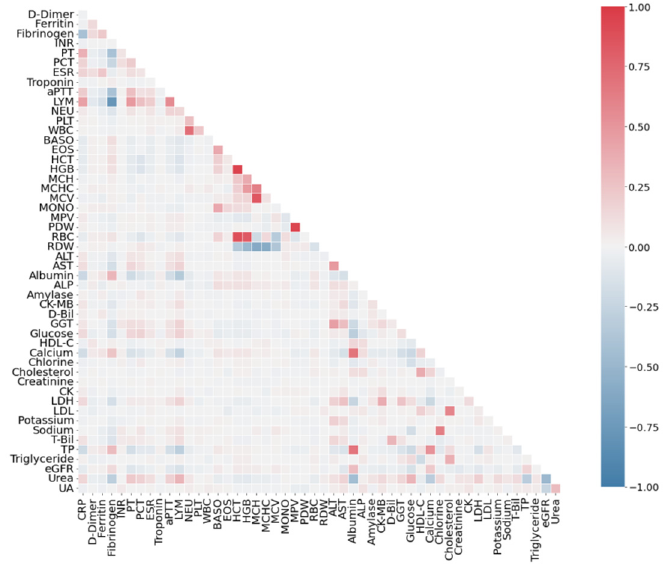
Figure 3. Pearson correlation analysis results for positive diagnoses for COVID-19 from the SARS- CoV-2-RBV1 dataset.